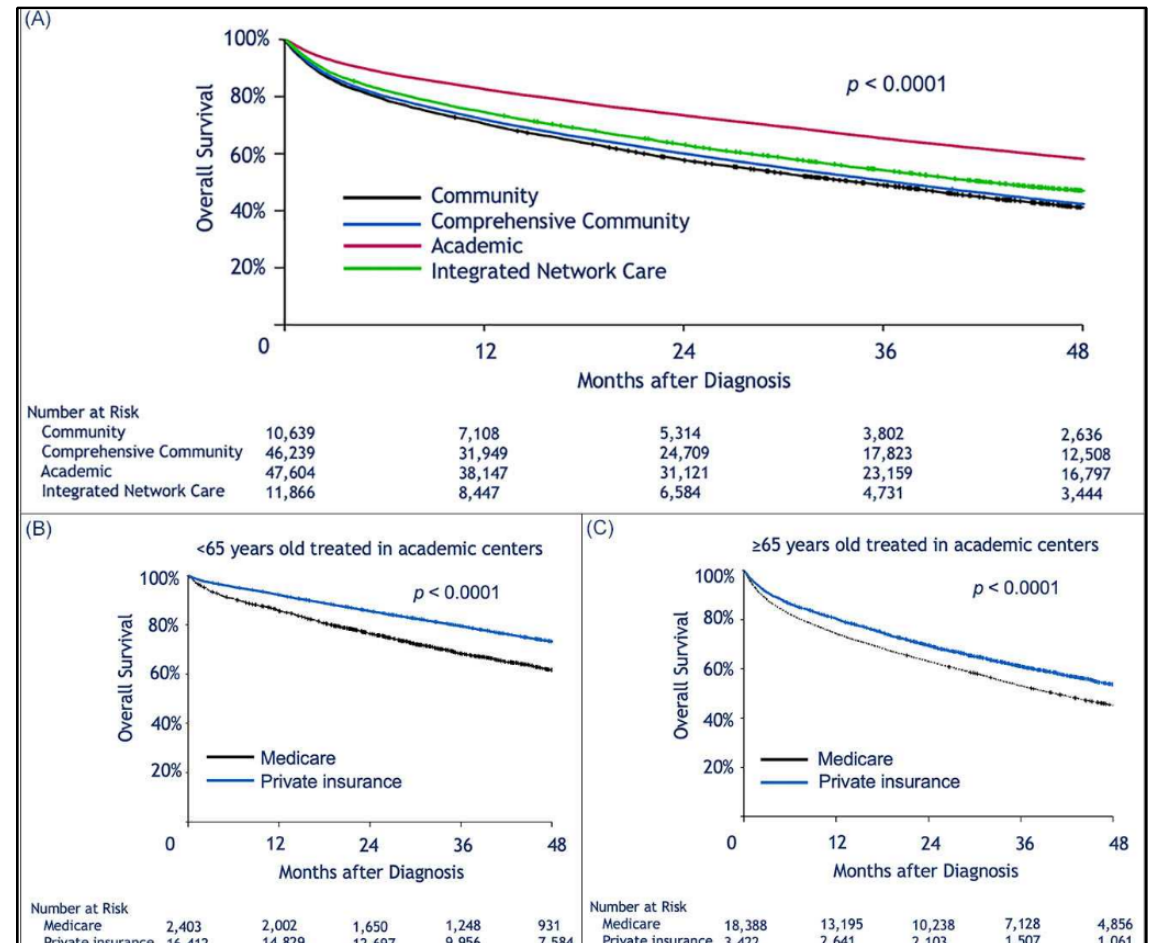
Figure 2. Kaplan–Meier estimation of overall survival comparing patients treated in different types of treatment centers. Treatment in an academic facility was associated with longer survival of multiple myeloma patients. However, privately insured patients treated at such facilities had better survival than those insured by Medicare. Kaplan–Meier estimation of overall survival as a function of: ( A ), treatment facility type; ( B , C ), show survival of patients privately insured or insured by Medicare who were treated at academic facilities; ( B ), patients aged <65 years; ( C ), patients ≥ 65 years old.